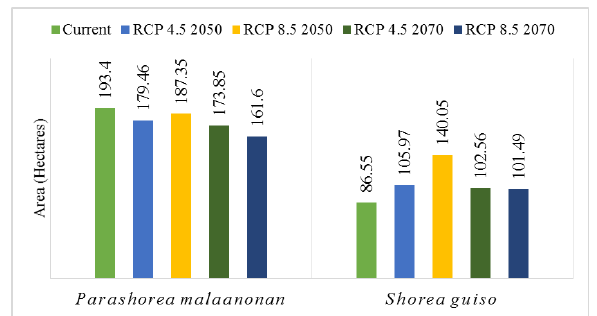
Figure 4. Current and future suitable areas of P. malaanonan and S. guiso under different climate